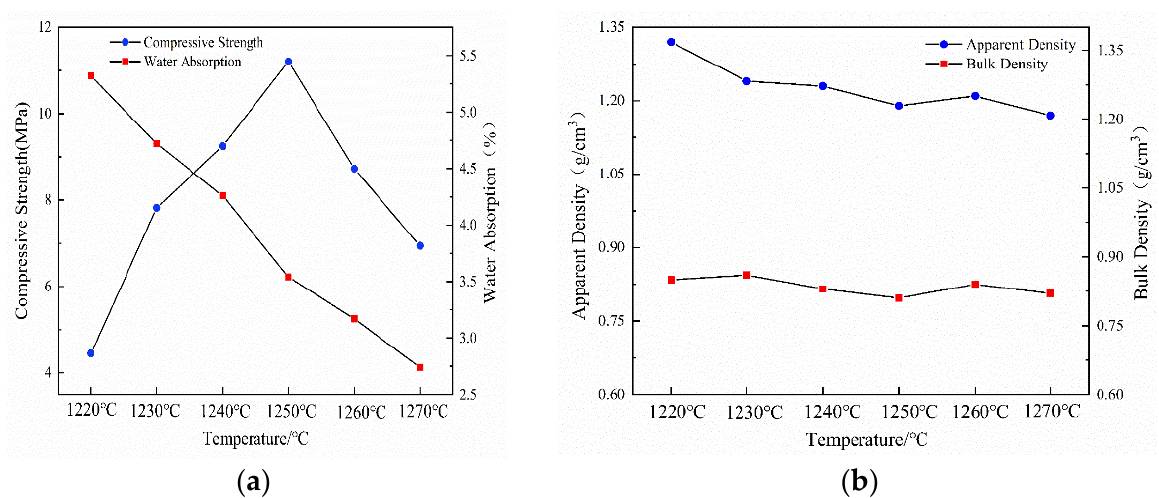
Figure 4. Properties of ceramsites at different temperatures ( a ) compressive strength and water absorption, and ( b ) apparent density and bulk density .